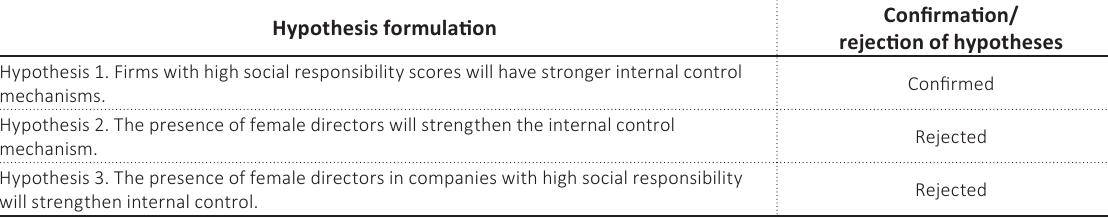
Table 8. Summary of study